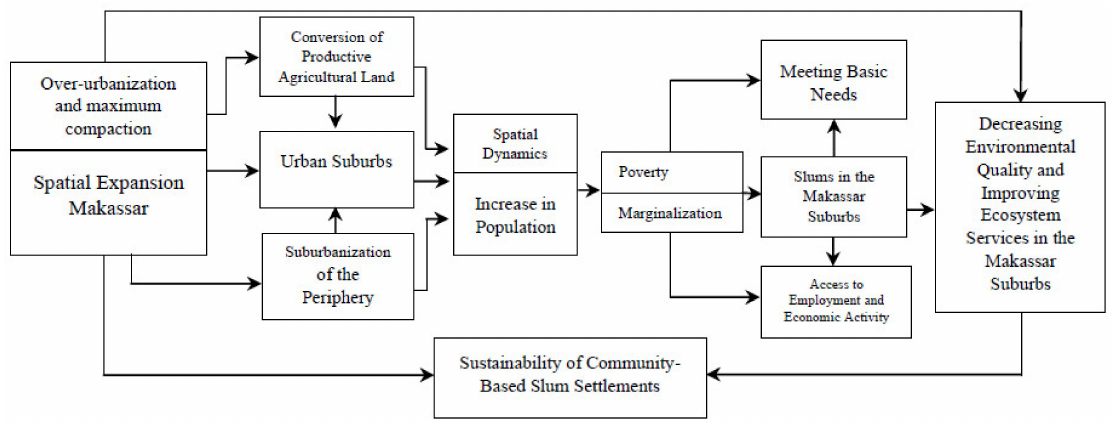
Figure 1. Conceptual framework for slum settlement in